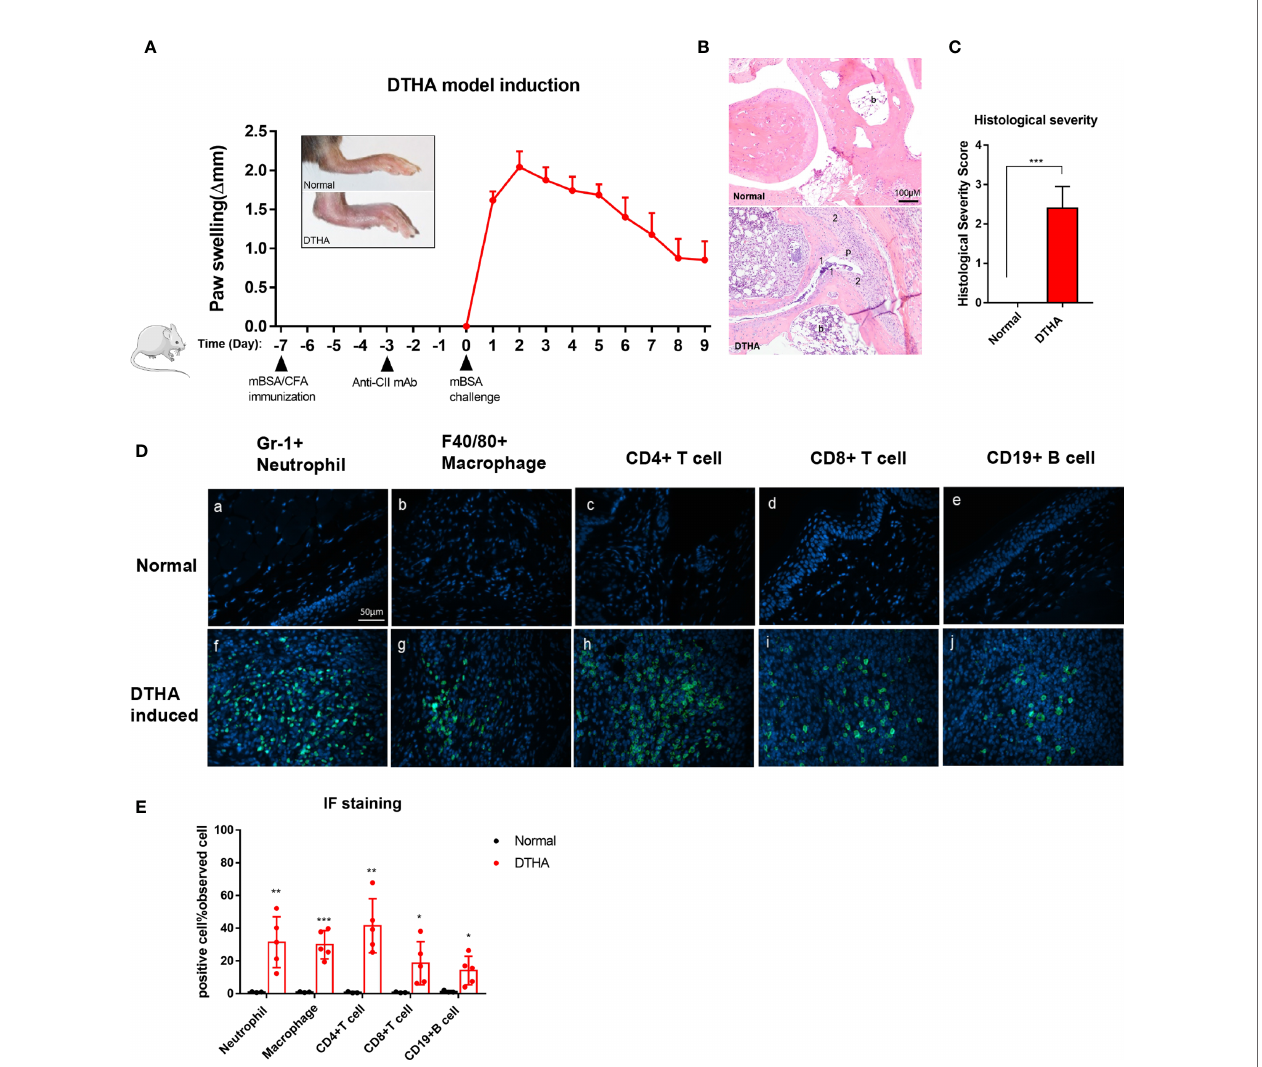
FIGURE 1 | Swelling, in fl ammatory severity score, and immune cell in fi ltration of paws induced by DTHA in mice. (A) The timeline of DTHA induction in mice by immunization with 100 µg mBSA on day minus 7 (day − 7), injection of anti-CII (50 mg/kg) on day − 3 and 200 µg mBSA challenge at day 0. Paw swelling was followed between day 0 and 9 post the fi nal 200 ug mBSA challenge. (B, C) Representative H&E stained sections (3.5 µM) of the paws (B) and histological severity score (C) from DTHA-induced and normal mice on day 9. Original magni fi cation is 200×; scale bar, 100 m m; b: bone marrow; p: pannus; 1: destruction of joint cartilage; 2: In fl ammation in fi ltration. Histology scores were calculated by the evaluation scale (see Materials and Methods ). (D) Representative images of immuno fl uorescence staining for neutrophils (Gr-1+), macrophages (F4/80+), CD4+ T cells (CD4+), CD8+ T cells (CD8+), B cells (CD19+) in fi ltrating paws from normal (a – e) and DTHA-induced mice (f – j) on day 9. Original magni fi cation, ×400; scale bar, 50 m m. Hoechst 33342 (blue colour) was used for nuclear counterstaining, while corresponding surface marker was shown in green colour. (E) Quanti fi cation of Gr-1+ neutrophils, F4/80+ macrophages, CD4+ T cells, CD8+ T cells, and CD19+ B cells. Values are expressed as the mean ± SD. All data are representative of two independent experiments with n = 3 in the normal group and n = 5 in DTHA group per experiment. Statistical signi fi cance was calculated by Student ’ s t -test to measure signi fi cant difference between normal group and DTHA group. (*p < 0.05, **p < 0.01, ***p < 0.001). The mouse image is from